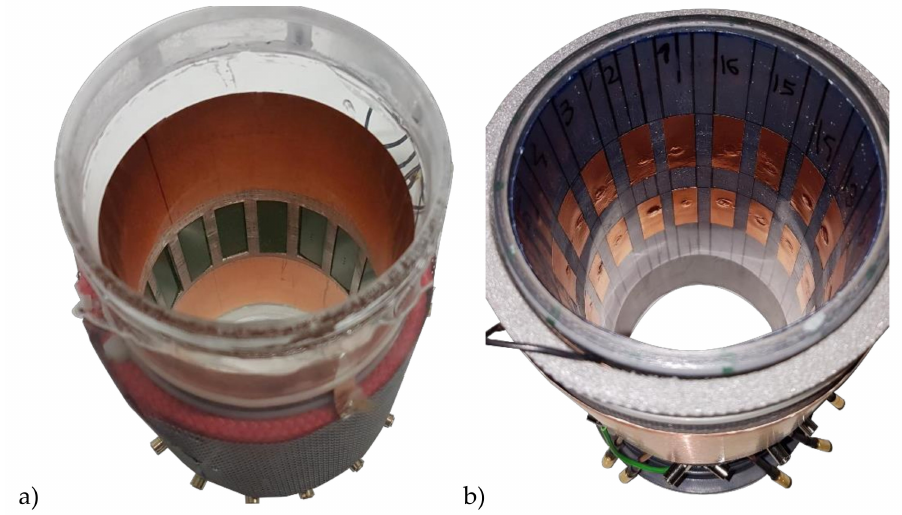
Figure 10. The ECT sensors used in the experiments: ( a ) 2D with 16 electrodes, ( b ) 3D with 2 rings of 16 electrodes